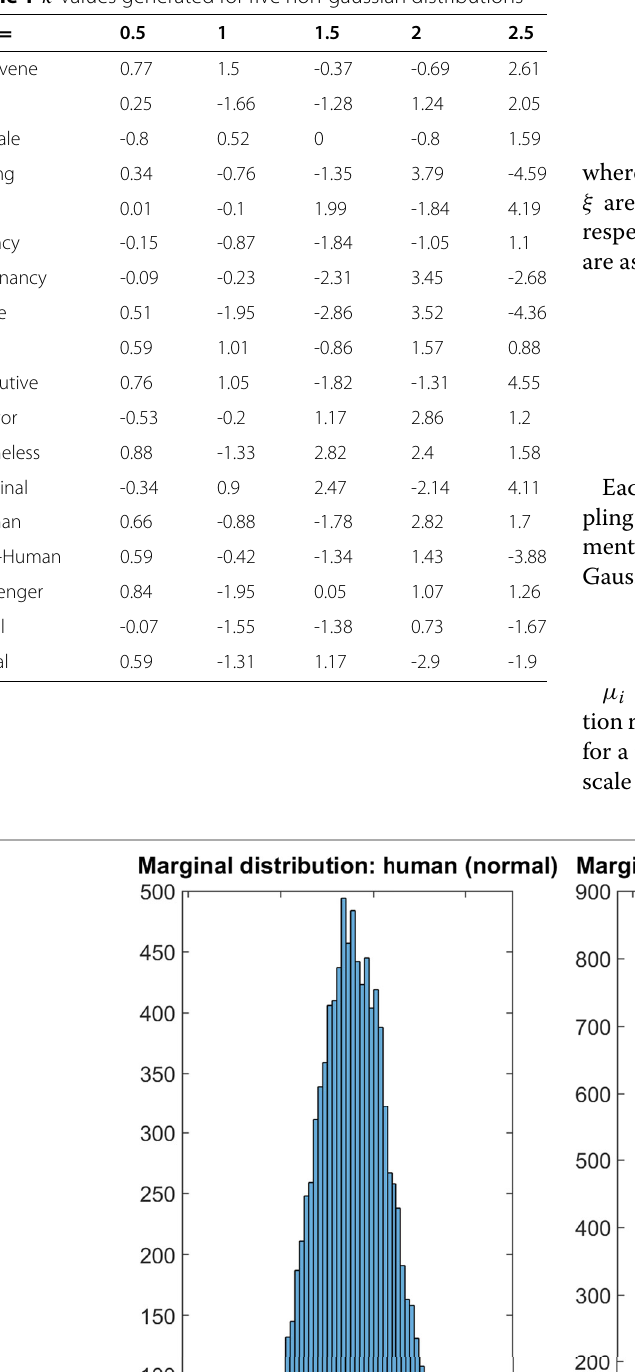
Table 1 κ values generated for five non-gaussian distributions